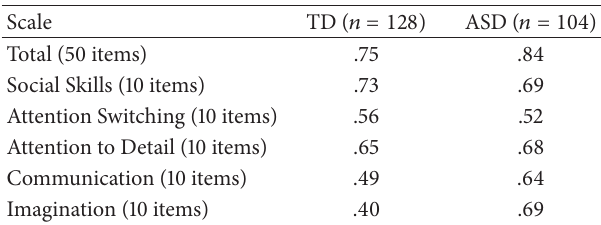
Table 2: Internal consistencies (Cronbach’s alpha) for all subscales of the AQ for TD and ASD